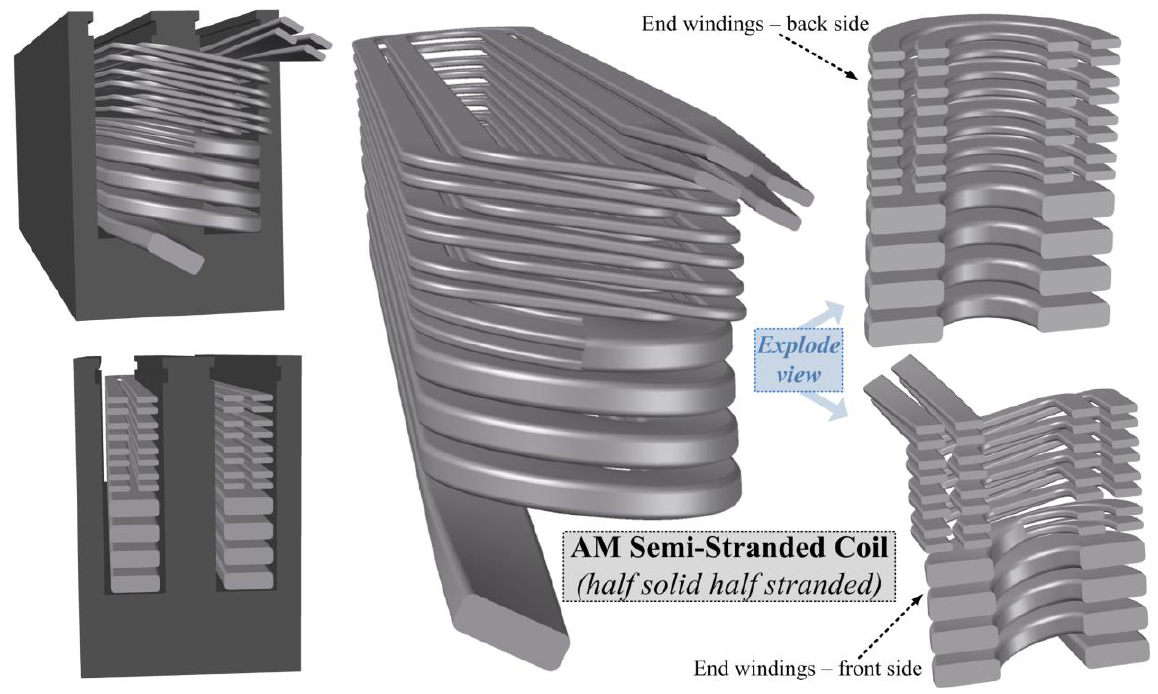
Figure 10. A novel semi-stranded coil design with transposed strand locations.